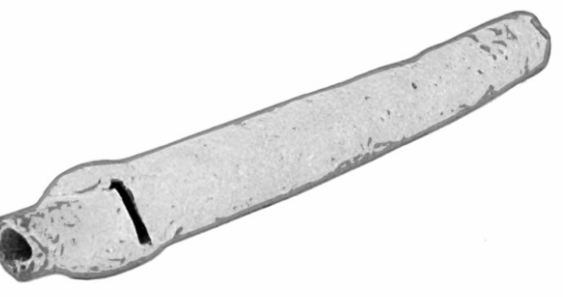
Figure 30. Piston whistle, Teotihuacan (MNA, Inv. 10-223558), length: 19.6 cm.